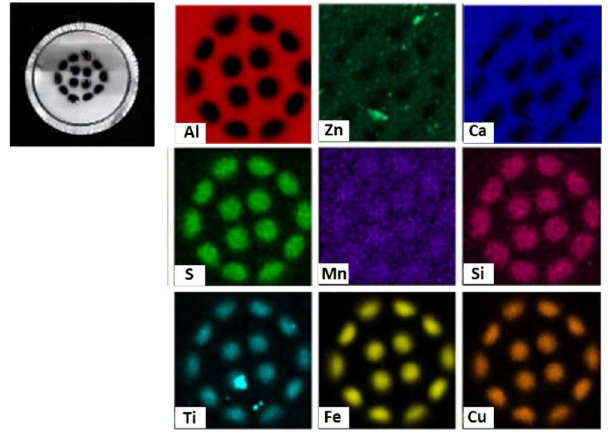
Fig. 5 XRF maps of the airborne wear particles collected on the aluminum foil of the ELPI+ impactor (stage 12), obtained from the FM4-BD1